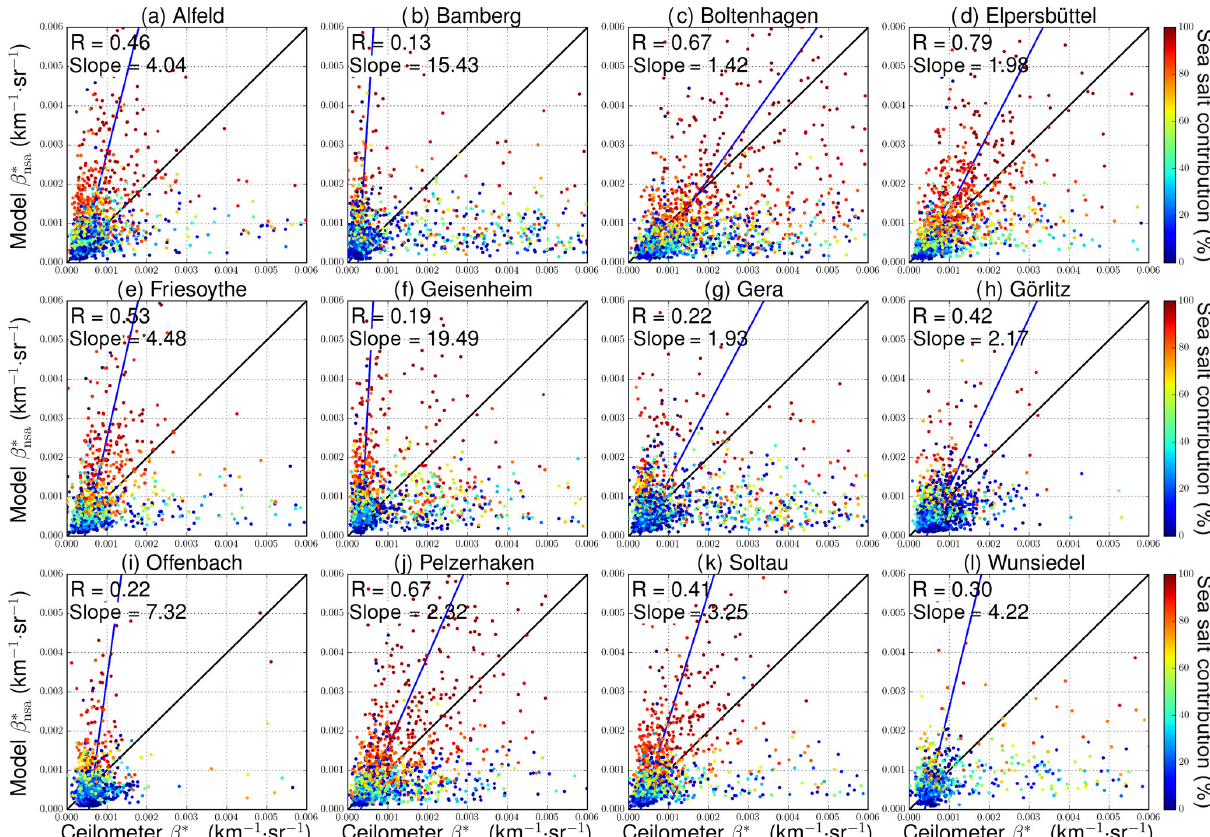
Figure 7. Scatter plots of the ceilometer and model surface attenuated backscatter signals for the 12 sites listed in Table 2. Model data are converted to attenuated backscatter signal based on hygroscopic growth factors introduced in Swietlicki et al. (2008). Color code represents the relative contribution of sea salt to backscatter signal. The blue curve indicates the total least squares regression line of the data point with at least 120 ceilometer profiles, while the black curve represents the 1 : 1 reference. Table 4. Comparison of selected optical properties at 1064nm of mineral dust particles assuming spherical and nonspherical shapes. Spheroid particles with an aspect ratio distribution measured by Kandler et al. (2009) are assumed for nonspherical dust particles. Spherical Nonspherical Difference Species Specific extinction Lidar Specific extinction Lidar in